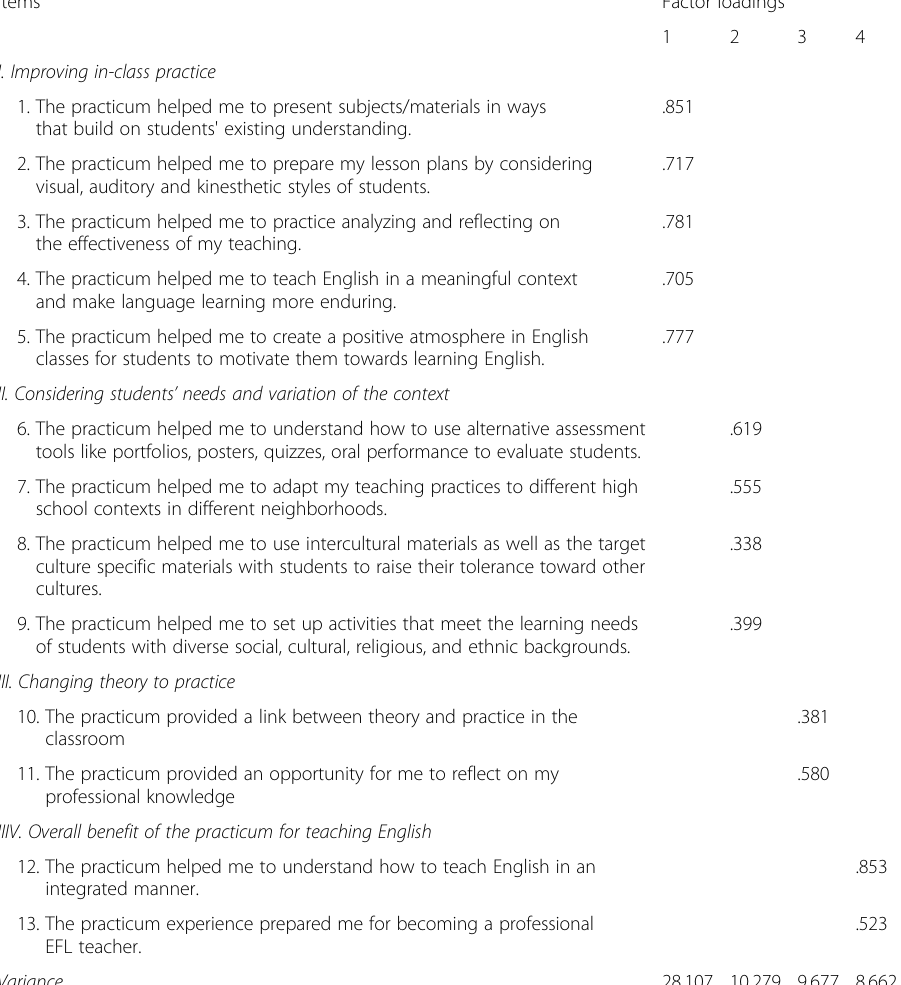
Table 2 Summary of items and factor loadings from factor analysis